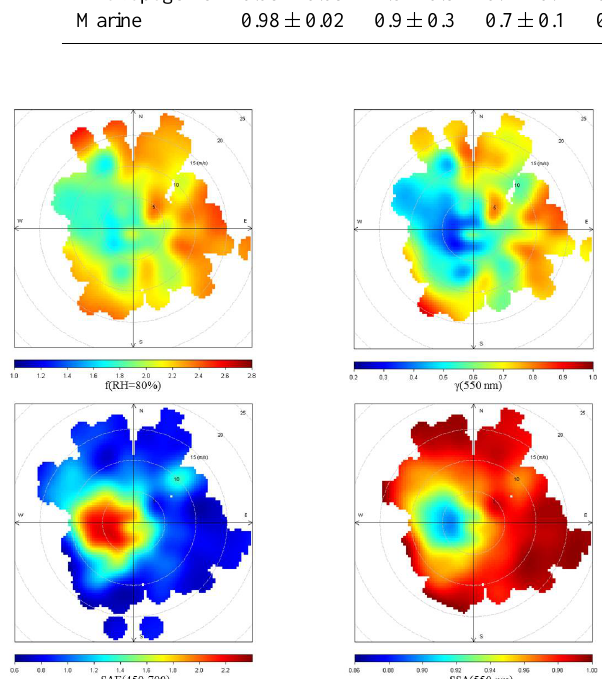
Figure 5. Bivariate plots of the scattering enhancement factor at 80% RH, the γ parameter, single scattering albedo and scattering Ångström exponent as a function of wind speed and direction. 4